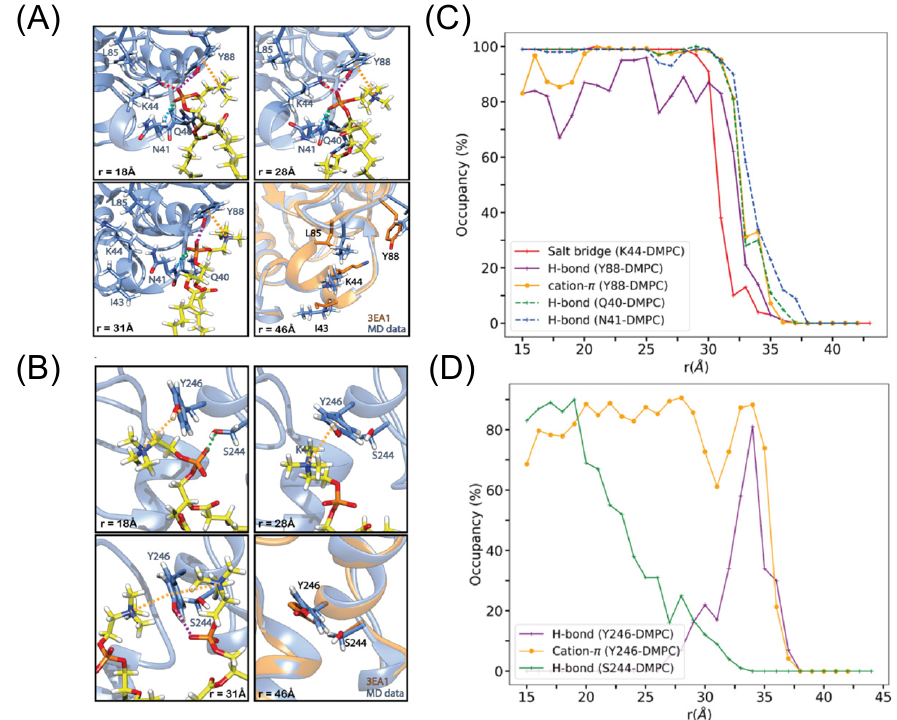
Figure 7. The Tyr88 and Tyr246 cation- π interactions with DMPC as Bt PI-PLC is separated from the membrane. The free energy minimum for bound Bt PI-PLC occurs at 18 Å. Snapshots of ( A ) Tyr88 and ( B ) TyrY246 interactions are shown at different distances from the membrane center during detachment from the DMPC bilayer. The Bt PI-PLC backbone, shown as blue ribbon, is aligned with a crystal structure backbone in orange. Selected side chains are shown as sticks colored by atom type; the DMPC, shown as sticks, has yellow C atoms. The dotted lines indicate the interactions between the protein and DMPC. The occupancies of the cation- π (orange), salt bridge (red), H-bonds (various colors indicated on each panel), for the ( C ) Y88 and ( D ) Tyr246 networks are plotted versus r 1 , the distance from the center of mass of the protein and that of the upper phosphate plane. Protein is fully desorbed by 38 Å. Reprinted with permission from Moutoussamy et al., (2022), J. Chem. Inf. Model (doi: 10.1021/acs.jcim.1c01543), Copyright 2022 the authors. There is limited experimental evidence consistent with this network of interactions stabilizing the Tyr88 cation- π complex. However, the variants Y88A and Y88W lend sup- port for the formation of a hydrogen bond between the hydroxyl group of Tyr88 and the DMPC phosphate (Figure 8). The Y88A protein has lost one of the cation- π interactions and its K d increases significantly with an increase in the ΔΔ G 0 bind of +2.5 kcal/mol for bind- ing pure DMPC bilayers (Figure 8). Y88W does recover some of the binding energy lost by Y88A, but the protein still does not bind as tightly (or more tightly, as expected for a choline cation–Trp- π complex) as unmodified Bt PI-PLC. The ΔΔ G 0 bind for Y88W compared to wild-type PI-PLC is +1 kcal/mol, equivalent to the loss of a hydrogen bond. It is likely that a cation- π interaction is intact in Y88W, but the hydrogen bond between the aromatic indole ring and the DMPC phosphate is not present. The larger indole ring in this position and perhaps the misalignment of the N-H on the indole ring could preclude formation of the H-bond with the PC phosphate group.